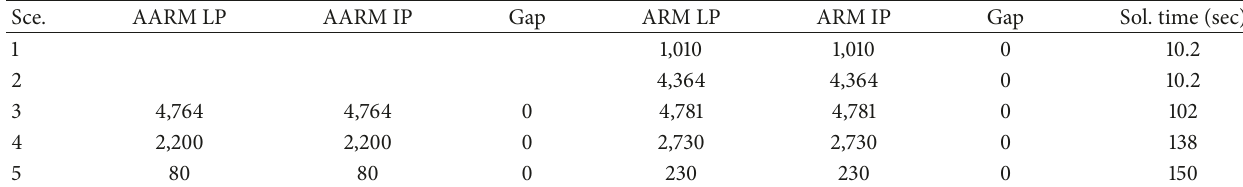
Table 3: Computational results of the two-stage heuristic for the five scenarios. Sce.